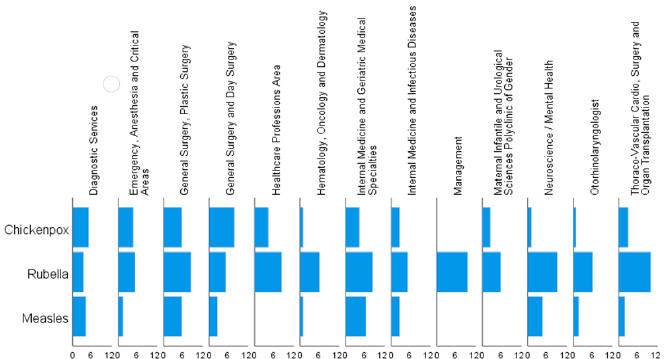
Figure 1. Prevalence of susceptibility towards measles, rubella and chickenpox, by type of wards.